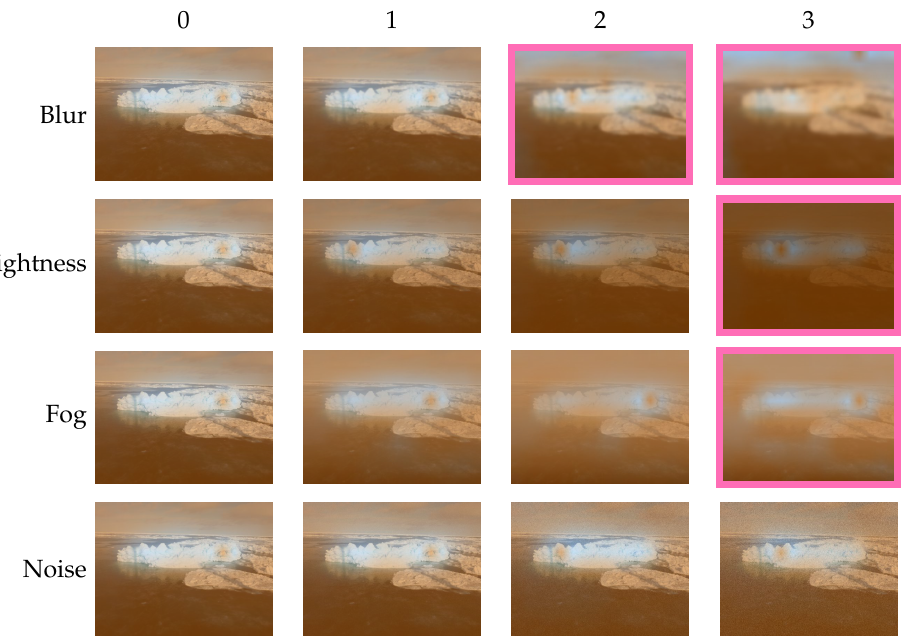
Figure 12. Grad-CAM images for activations of the class floeberg with different levels of distortions. The images with a pink border were not classified as floebergs by the network. Image rights: Løset Sveinung